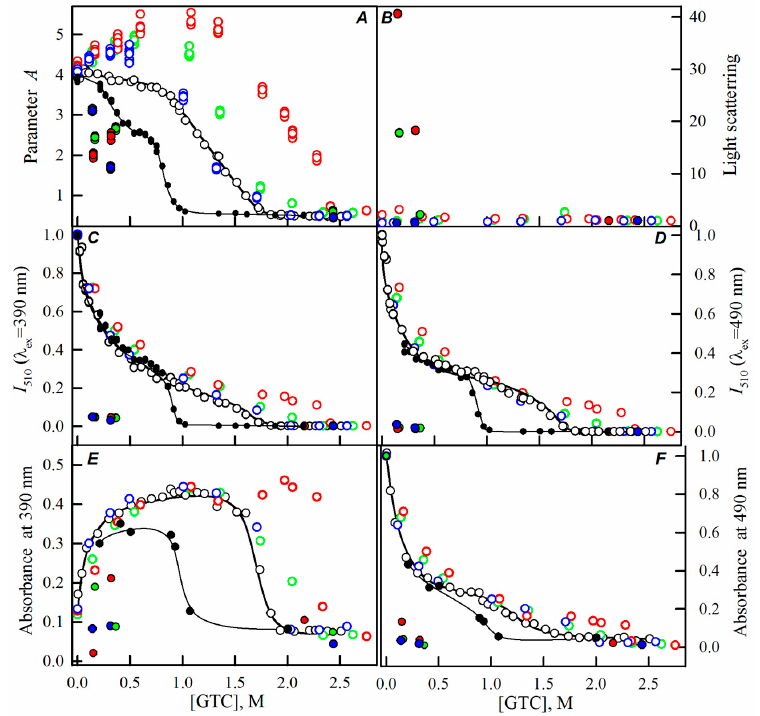
Figure 4. The effect of crowding agent PEG-600 on the sfGFP conformational changes induced by GTC. For more details see the legend of Figure 2. Applied concentrations of PEG-600 were 8% (blue circles), 20% (green circles), and 30% (red circles).